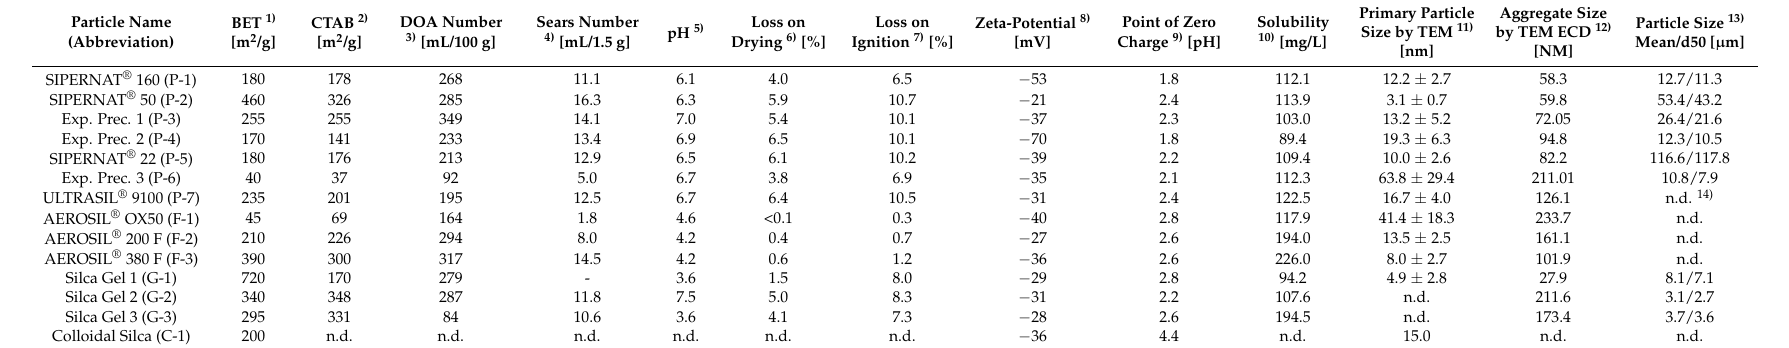
Table 1. Material properties of the synthetic amorphous silica (SAS) used in the